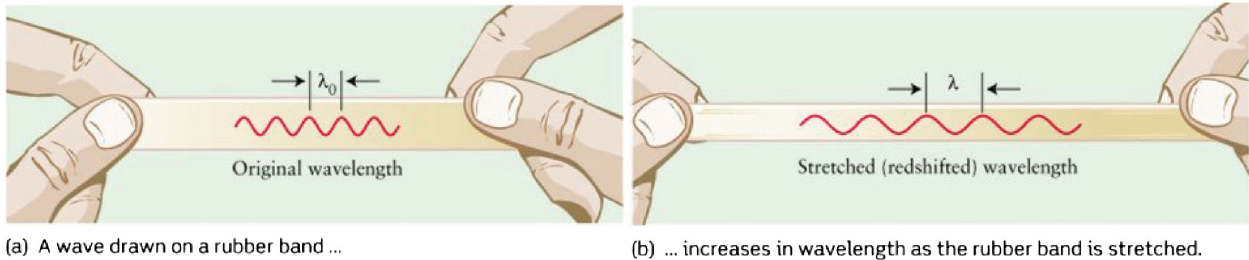
FIG. 22. Cosmological redshift, the expansion of space causing the wavelength of electromagnetic radiation to be stretched. Image credit: Freedman, Geller and Kaufmann [101]. Used